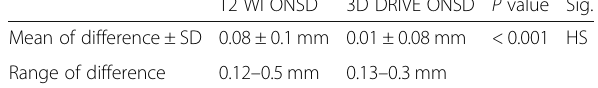
Table 4 The inter observed variability. The ONSD mean value and range of the difference between the first and the second reader in both 3D DRIVE and T2WI sequences T2 WI ONSD 3D DRIVE ONSD P value